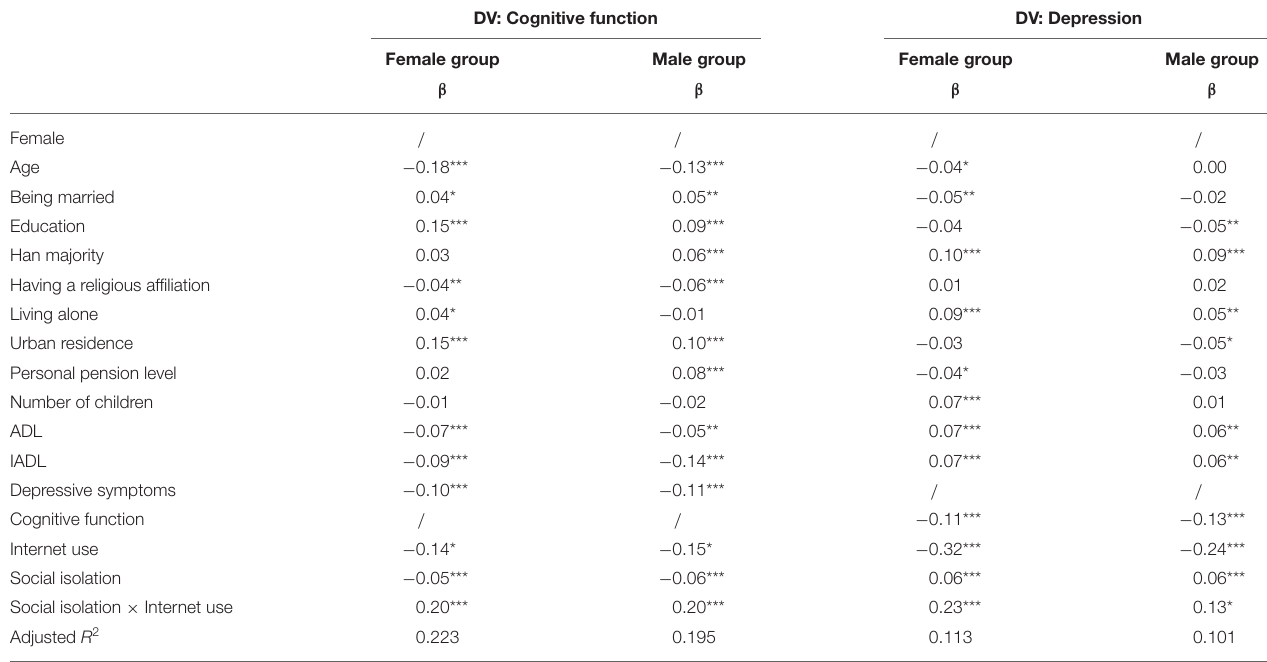
TABLE 4 | Results of linear regression model for moderating effects in the relationship between social isolation and cognitive function/depression across gender groups ( N = 8,835). DV: Cognitive function DV: Depression Female group Male group Female group Male